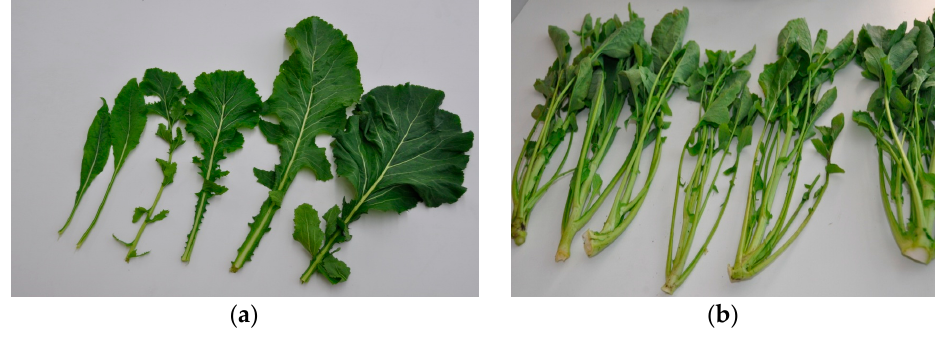
Figure 1. ( a ) Turnip greens; ( b ) turnip tops.